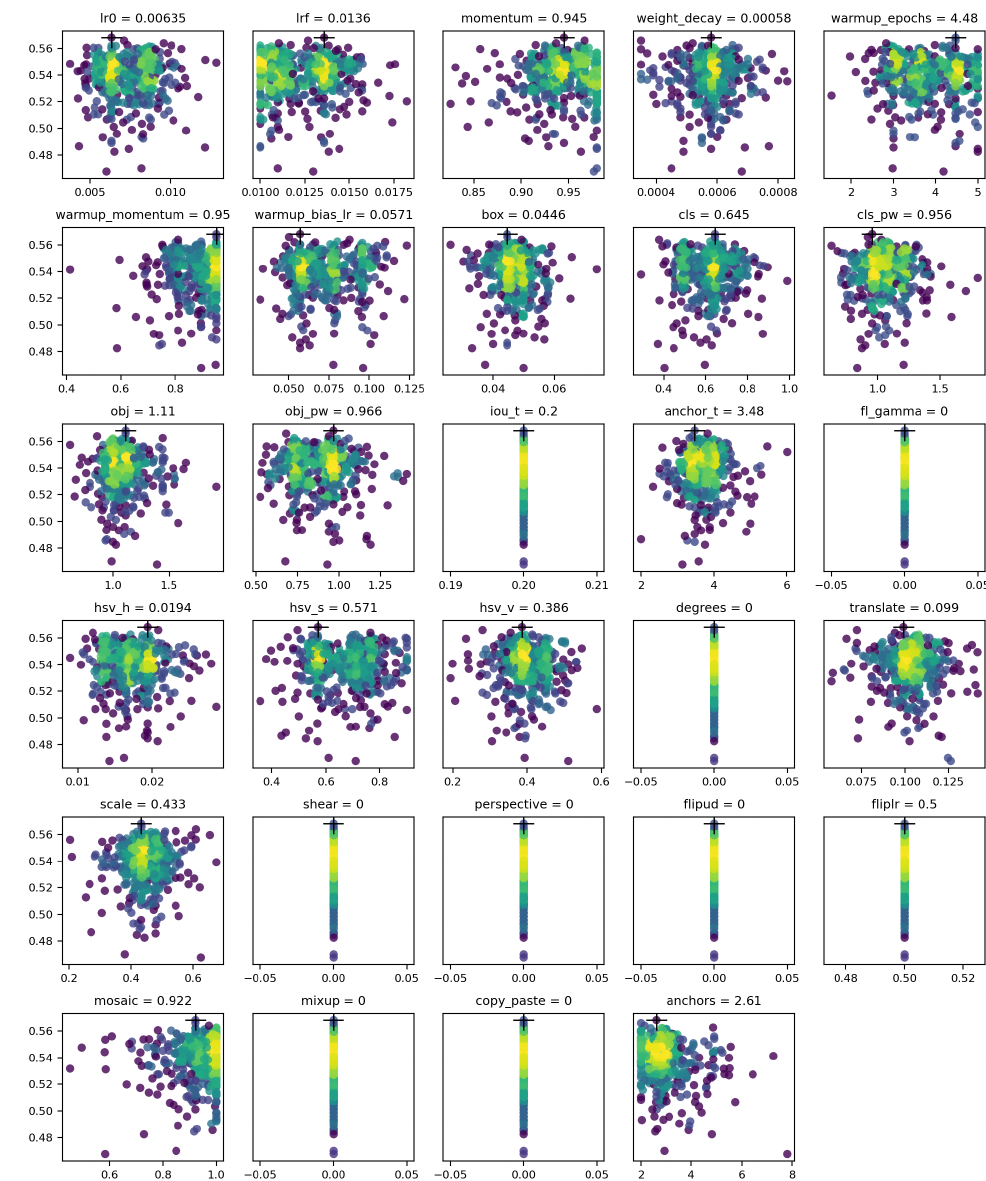
Figure 4. Graphical representation for the calculated values of all hyperparameters, after evolving for 600 generations for